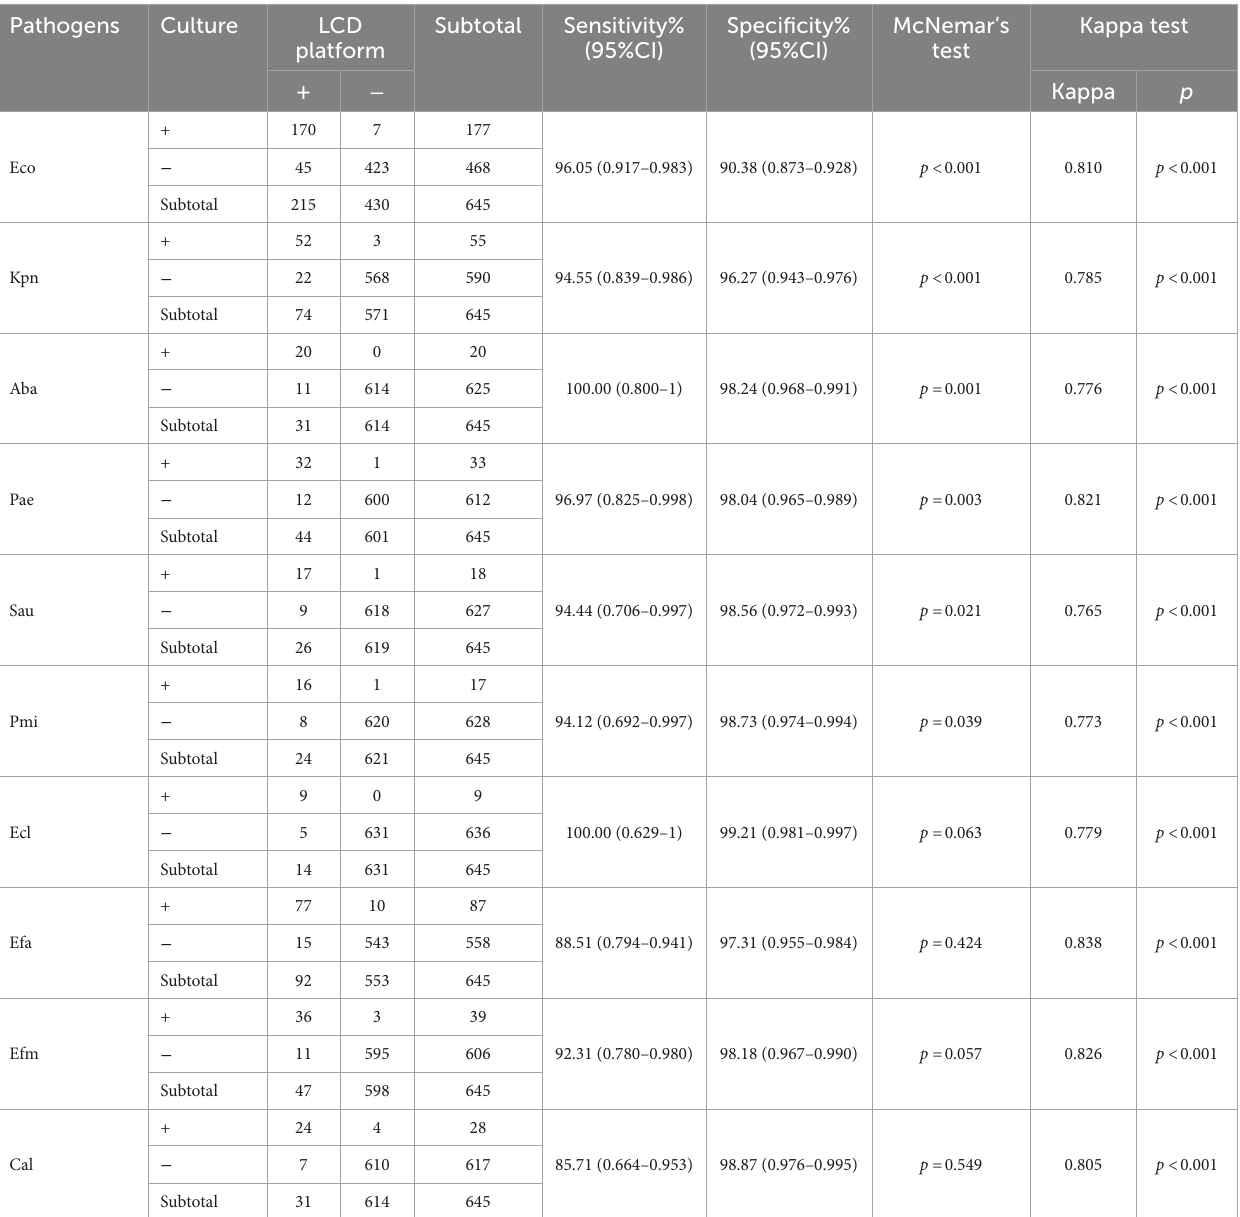
TABLE 1 Comparison of the coincidence rate of pathogens detection between the LCD platform and culture methods.